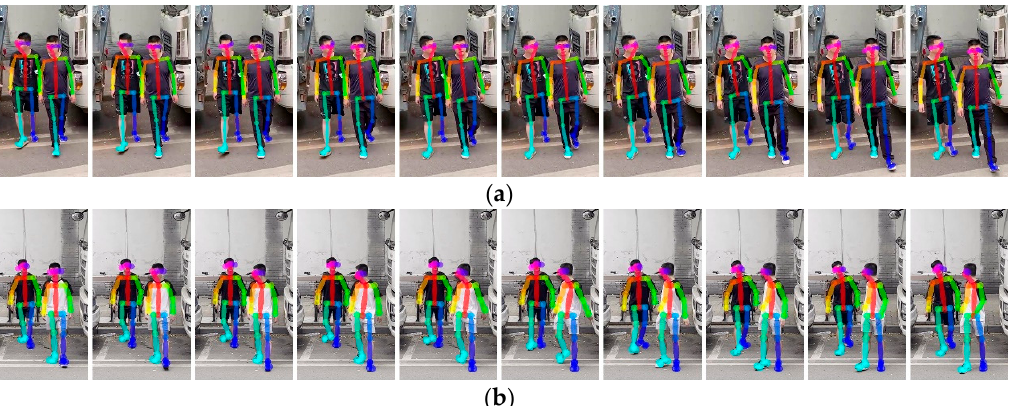
Figure 10. Pedestrian interference recognition experiments: ( a ) calculated result had no behavioral interference between the two people, and ( b ) calculated result had behavioral interference between the two people. Table 4. Comparison results of input parameters for pedestrian interference recognition. Recogni- tion Accuracy (Acc.), Recall (Rec.), F1-score (F1.), Precision (Pre.). Min, Max, and Average (Ave.) results. Variable Acc. Rec. F1. Pre. Distance [8]